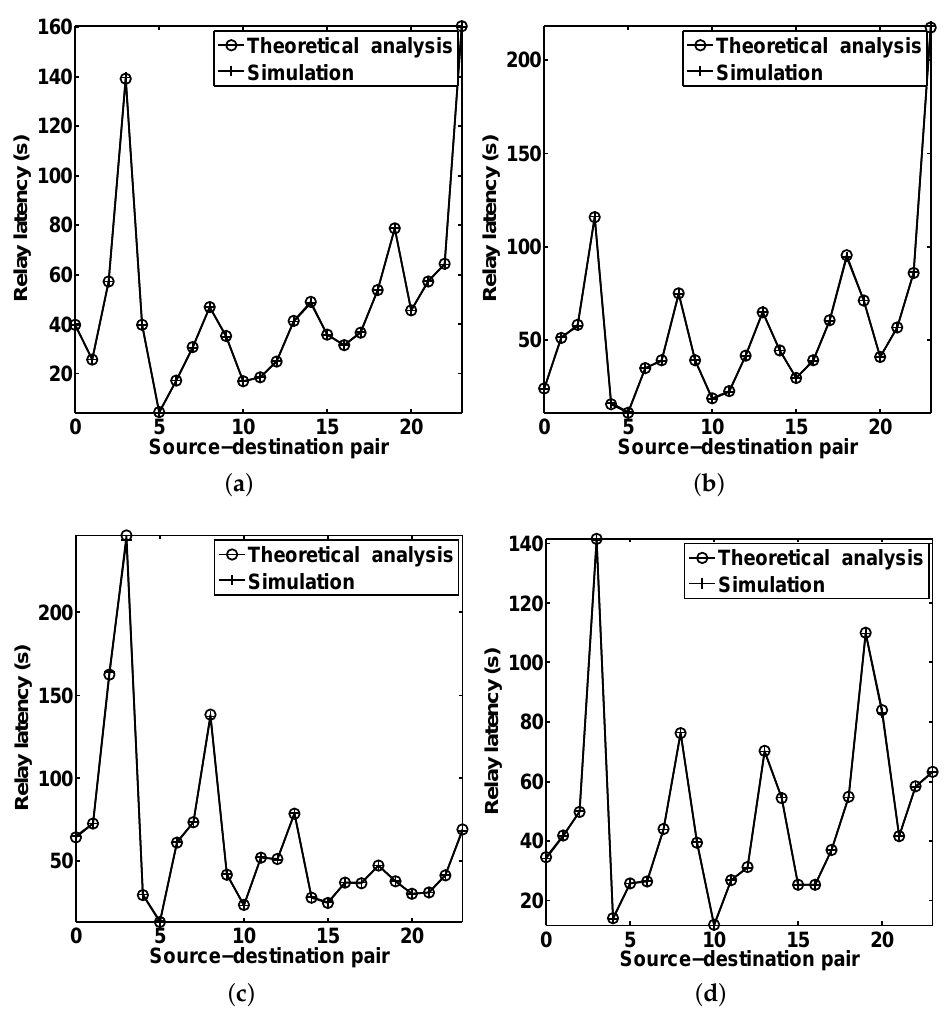
Figure 5. Average relay latency of the basic HERO algorithm, which is the duration from the time when the source sends the data to the first relay to the time when the data is delivered to the destination zone. ( a ) Relay 1; ( b ) Relay 2; ( c ) Relay 3; ( d ) Relay